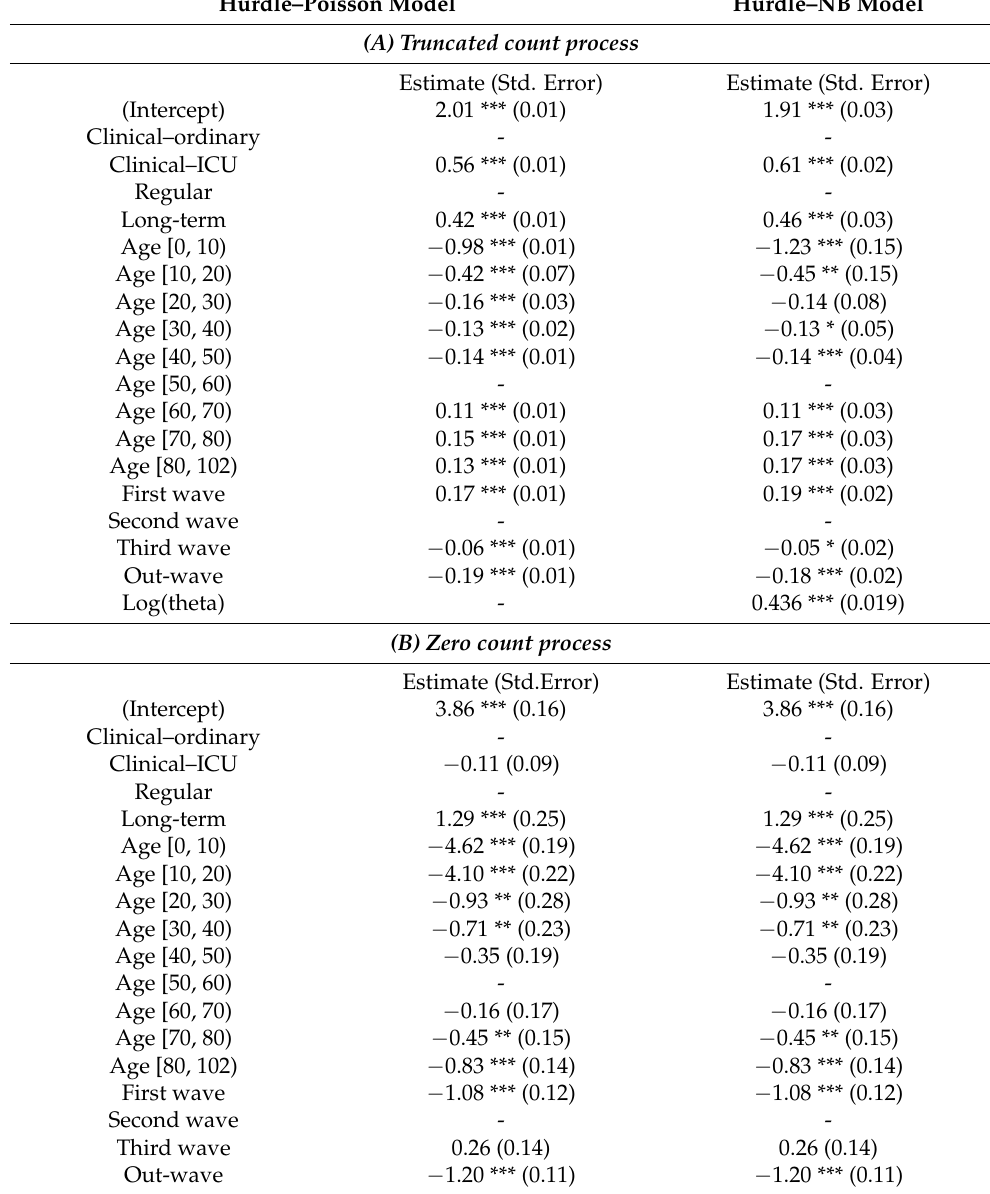
Table 3. Coefficients of the Hurdle–Poisson and Hurdle–NB models for the count